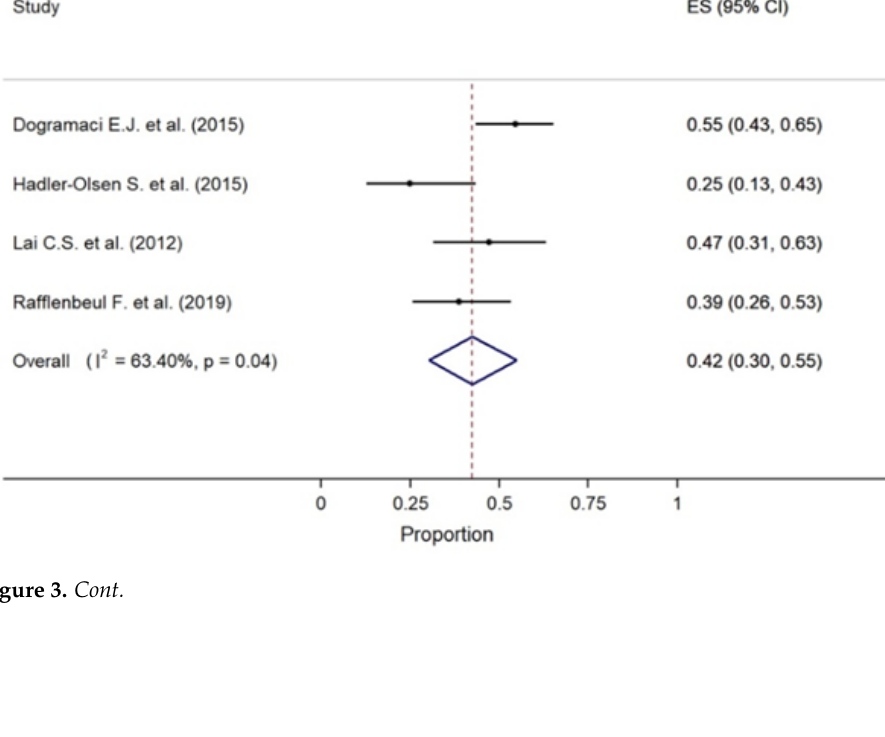
Figure 2. Forest plot with the prevalence of root resorption on patients with impacted canine [26–32].